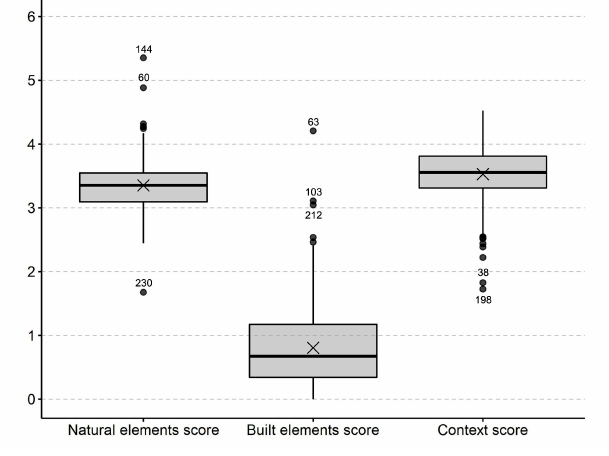
Fig. 6 . Boxplots for park quality dimension scores based on summed up values of single indicators (each normalized to a range from 0 to 1). Mean value marked with a cross. Numbers above or below dots represent the park IDs of